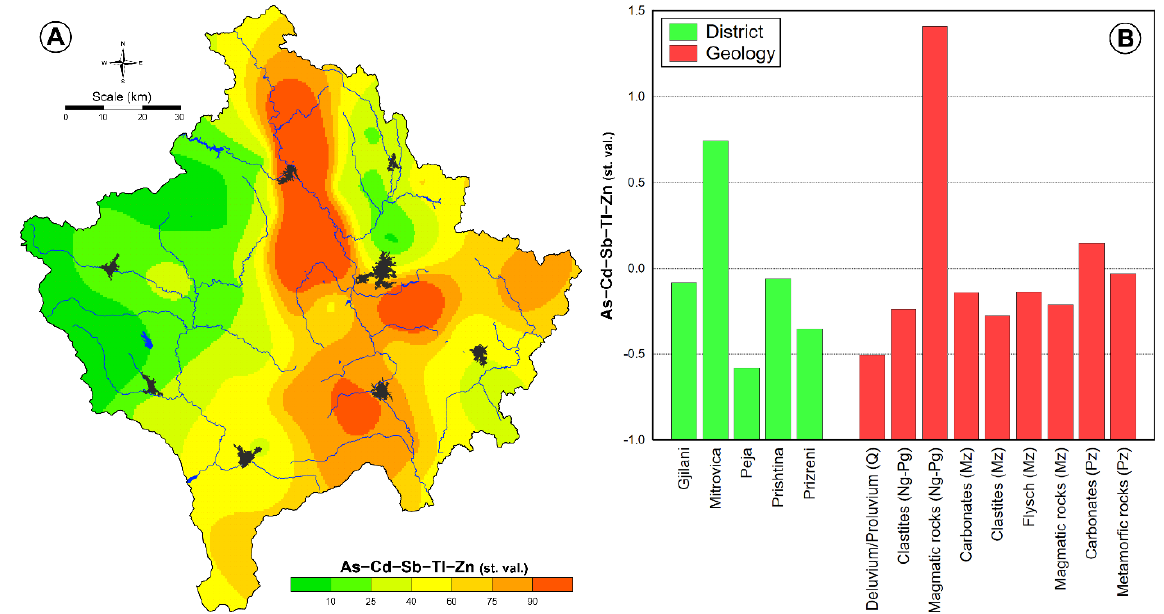
Figure 6. Spatial distribution of factor scores of F2 ( A ) and standard values according to the districts and geological formations ( B ).